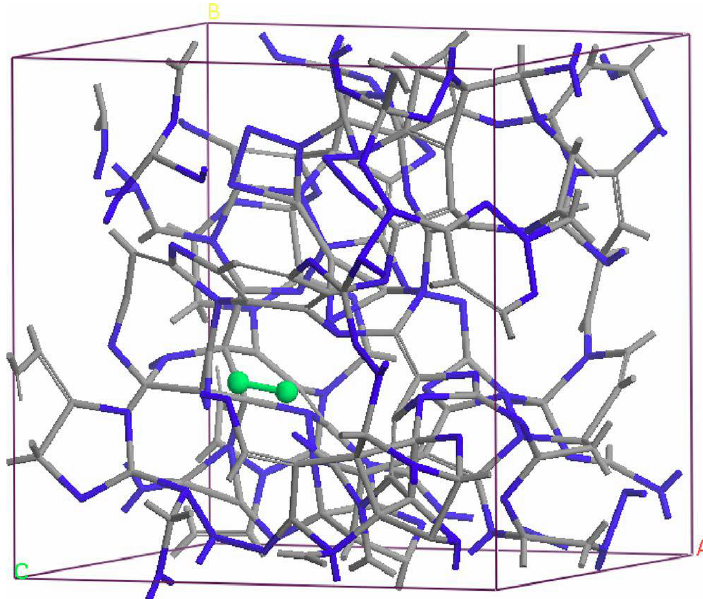
Figure 20. At a concentration of 44.9% of nitrogen, N dumbbell), well within the saturation region. Light gray sticks correspond to carbon, blue sticks correspond to